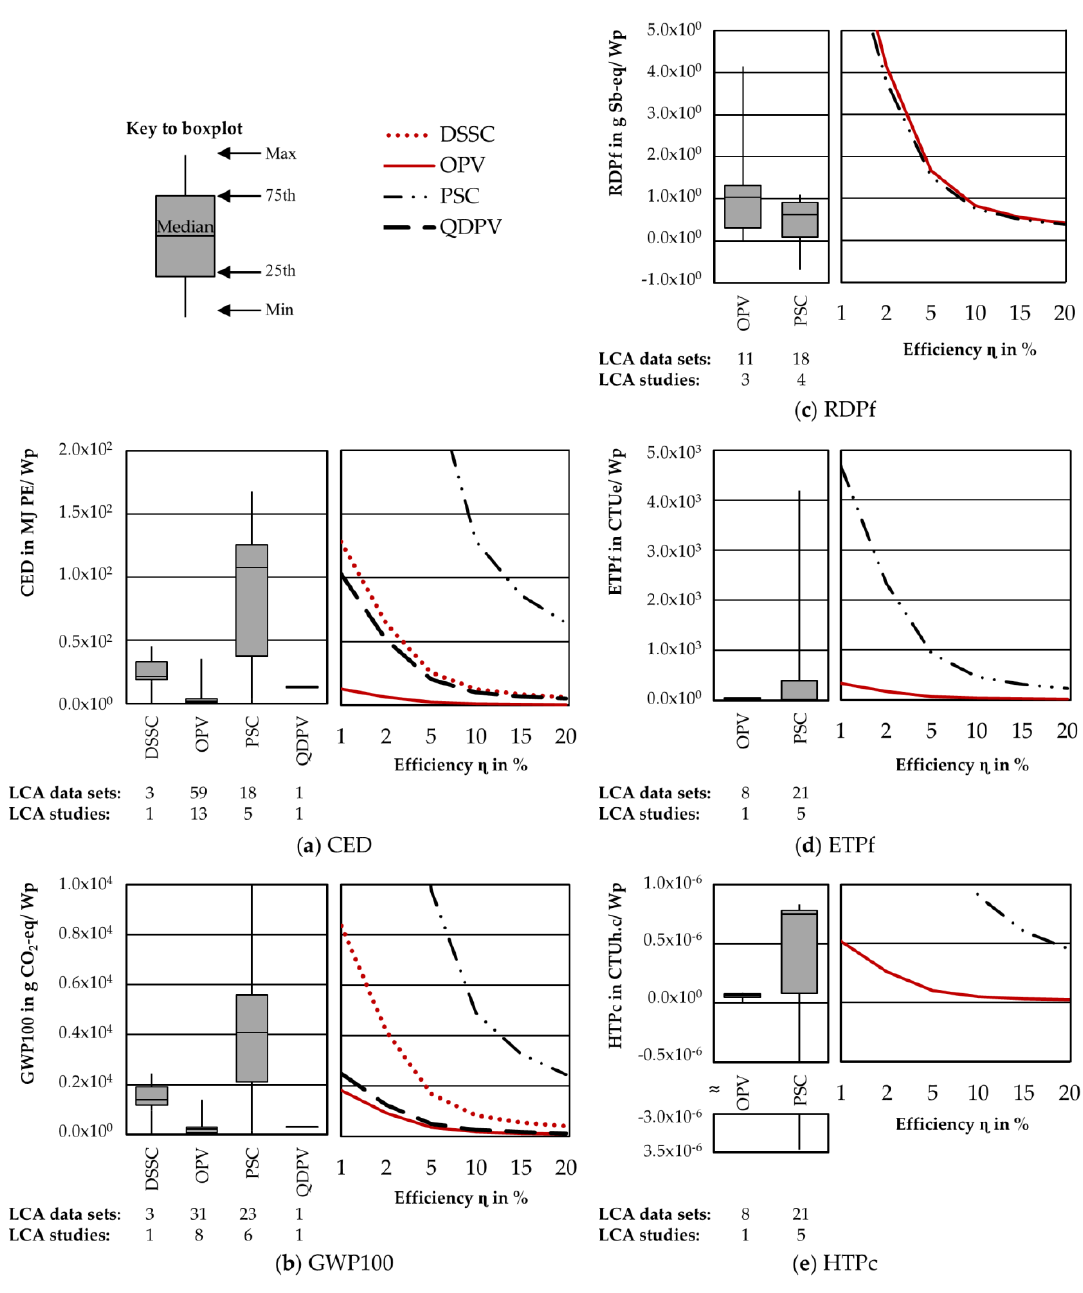
Figure 2. Current environmental status quo. Boxplots of the five key indicators (KEYIs) harmonized to the consistent functional unit of 1 W p and standard values of the efficiencies (Table 3) (left), as well as influence of the efficiency range (1–20%) on the medians (right).